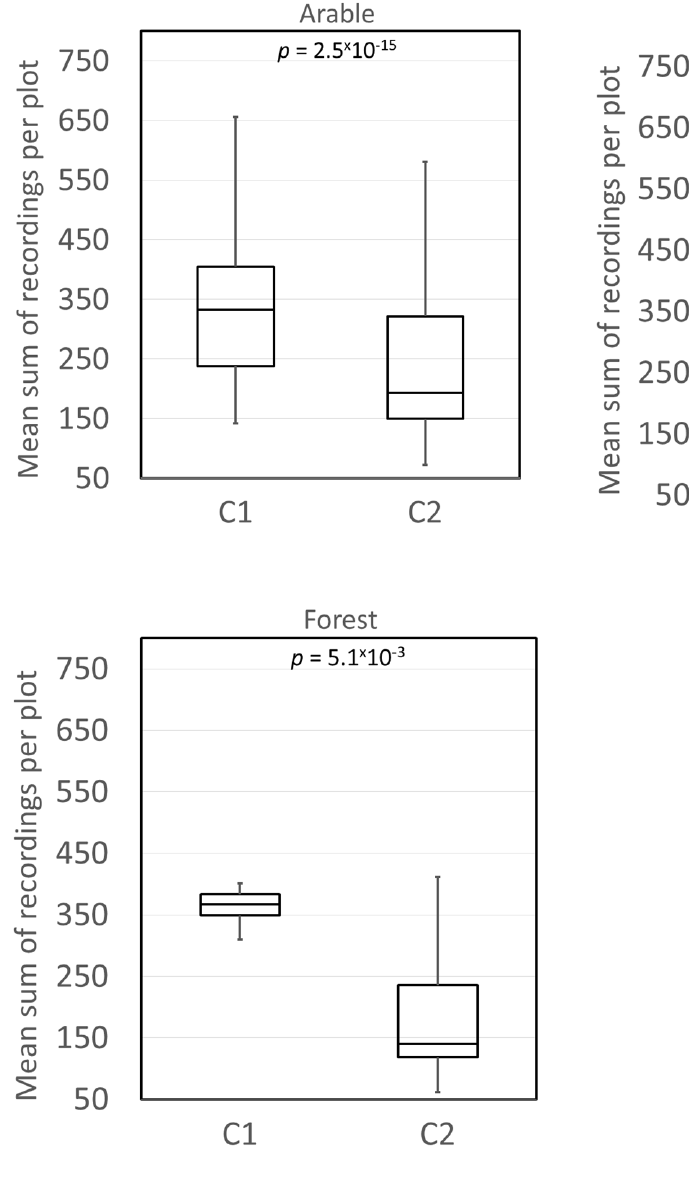
Figure 6. Comparison of abundance in the two observation campaigns (C1: 1999–2002; C2: 2013–2015) separated for different habitat types (for details see Tables S8 and S9 in the Supplementary Materials) p of Wilcoxon signed rank test.